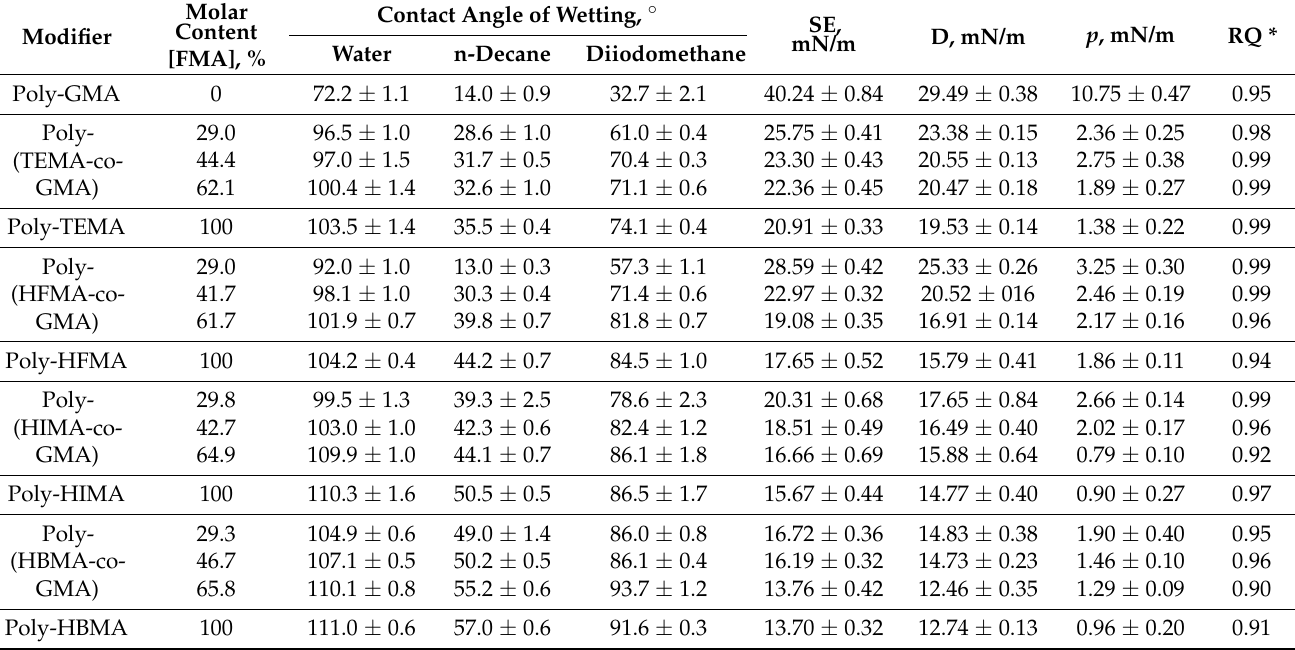
Table 2. Initial contact angles and surface energy of glass samples modified with GMA and FMA